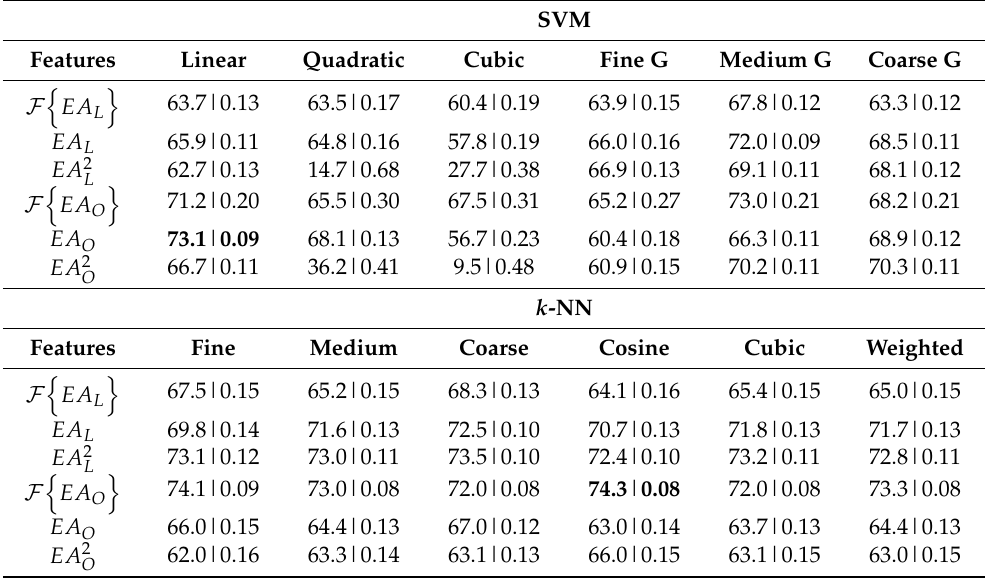
Table 7. Non-linear wear-state classification results ( % ) and normalised MAE for envelope analysis features, where G denotes